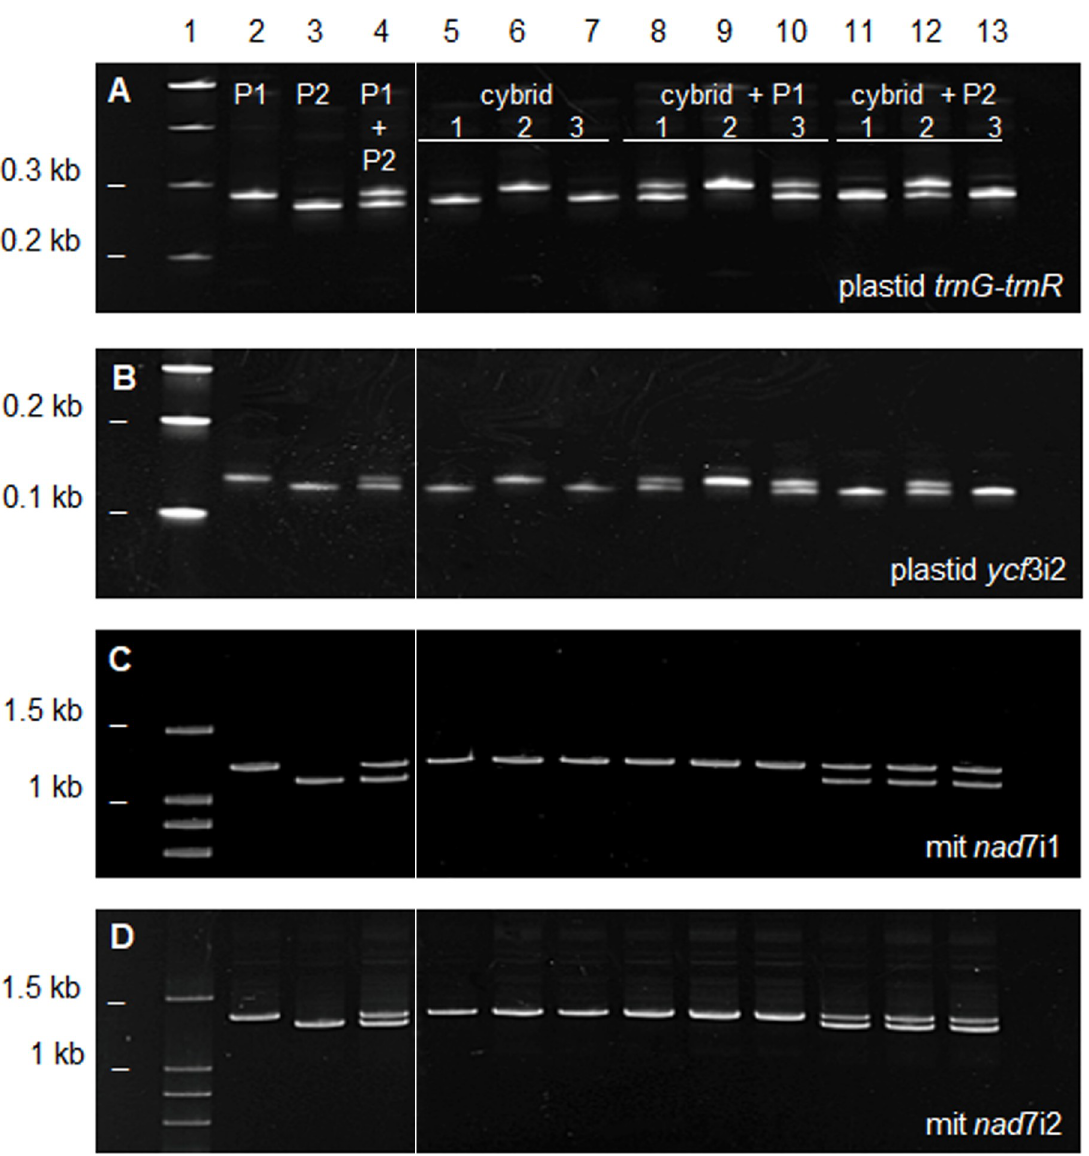
Fig 3. Organelle genome polymorphisms and inheritance in ‘Page’ mandarin and finger lime somatic cell fusion partners and products. PCR amplification products of fusion parent lines and fusion products are shown fractionated by polyacrylamide gel electrophoresis, stained with ethidium bromide and imaged on a Bio-Rad ChemiDoc ™ Gel Imaging System. Panels A, B, C and D show the plastid trnG - trnR intergenic spacer, plastid ycf3i2, mitochondrial nad 7i1 and mitochondrial nad 7i2 amplification products, respectively. In all panels, lane 1 contains the Promega G210A 100 base pair marker ladder; lane 2 the ‘Page’ mandarin (P1) amplification product, lane 3 the finger lime (P2) amplification product and lane 4 a mixture of P1 and P2 amplifications, confirming length polymorphisms. Lanes 5–7 carry amplifications from three independent 2N fusion products. To confirm the cybrid nature of the 2N plants recovered following somatic cell fusion, amplification products of each were mixed with those of P1 (lanes 8–10) or P2 (11–13), demonstrating all to carry the P2 mitochondrial genome and either the P1 or P2 plastid genome. The white line after the lane 4 indicates the cropped area of the gel. Complete uncropped gel image is available as S1 Fig.